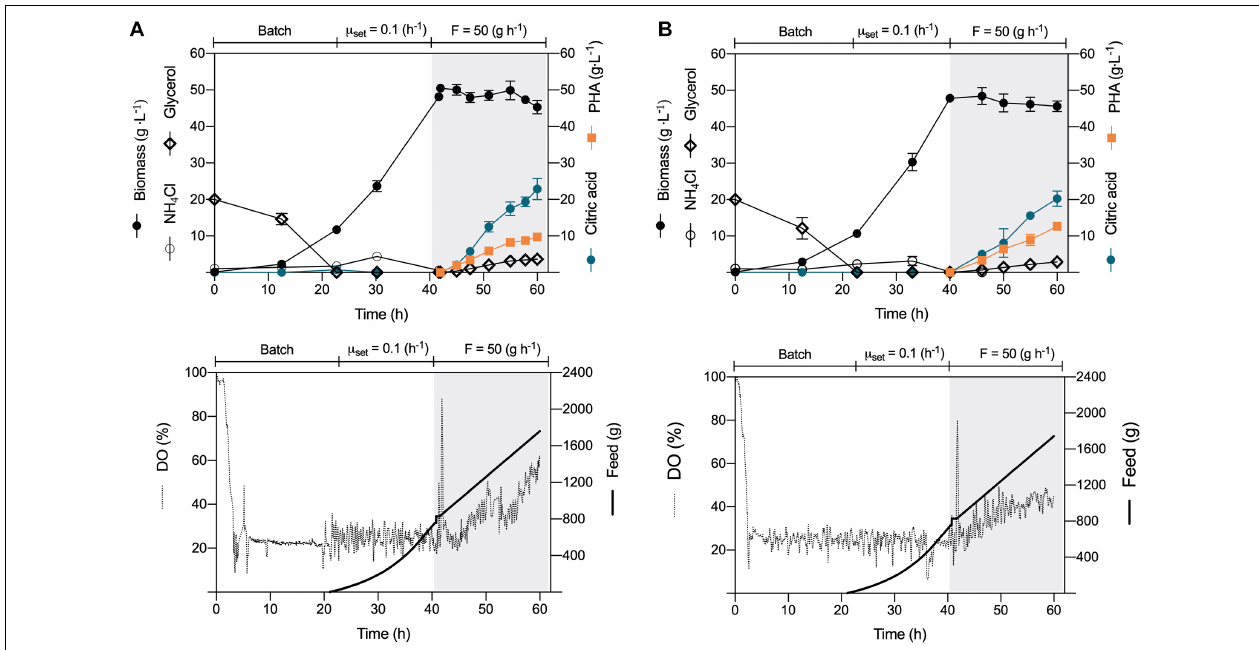
FIGURE 1 | Constant-feeding fed-batch mcl -PHA production. The fermentation process comprised three phases: (i) batch, (ii) exponential feeding, and (iii) constant feeding of crude glycerol (50 g h − 1 ) under nitrogen depletion. Time profile of (A) P. putida KT2440 and (B) phaZ -knockout mutant. The data represent the mean values and standard deviation from two independent experiments.